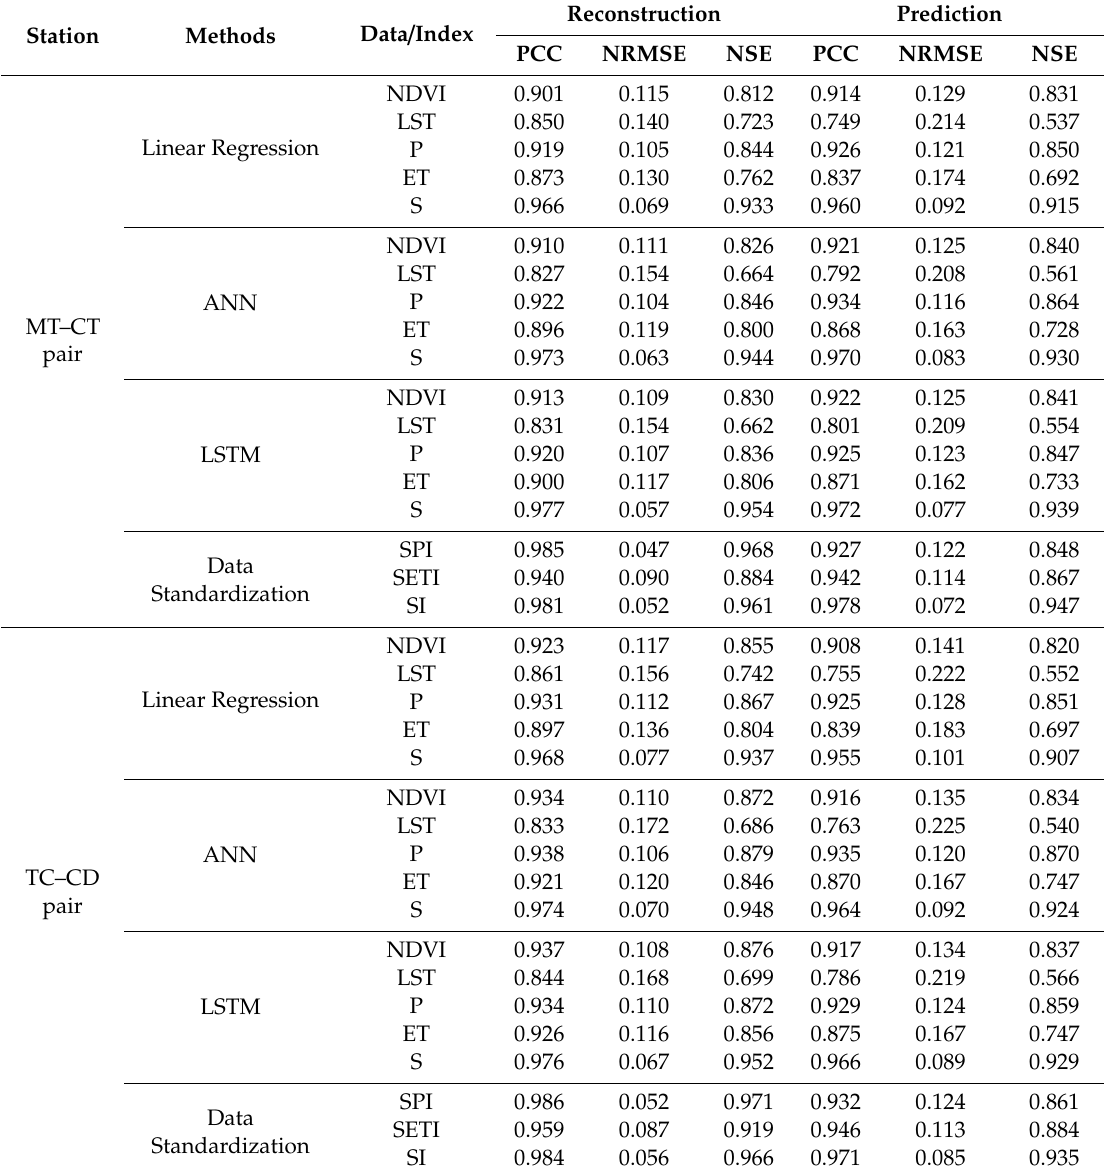
Table 4. Assessment of runo ff reconstruction and prediction at My Thuan–Can Tho (MT–CT) station pair, and Tan Chau–Chau Doc (TC–CD) station pair over the whole upstream